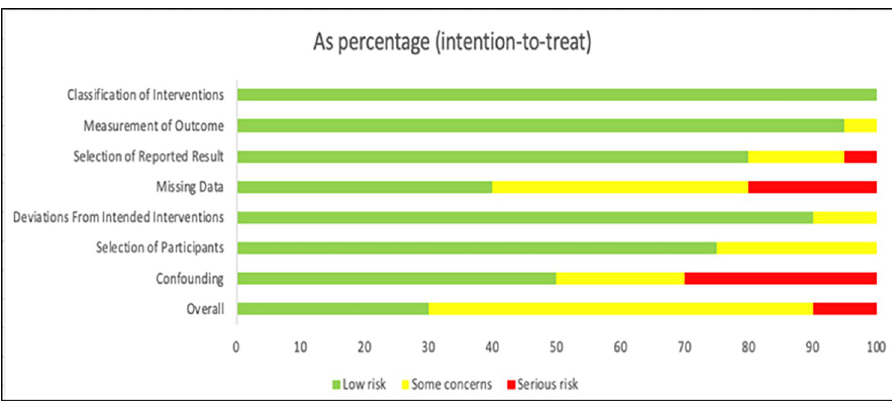
Fig 3. ROBINS-I assessment of risk of bias in